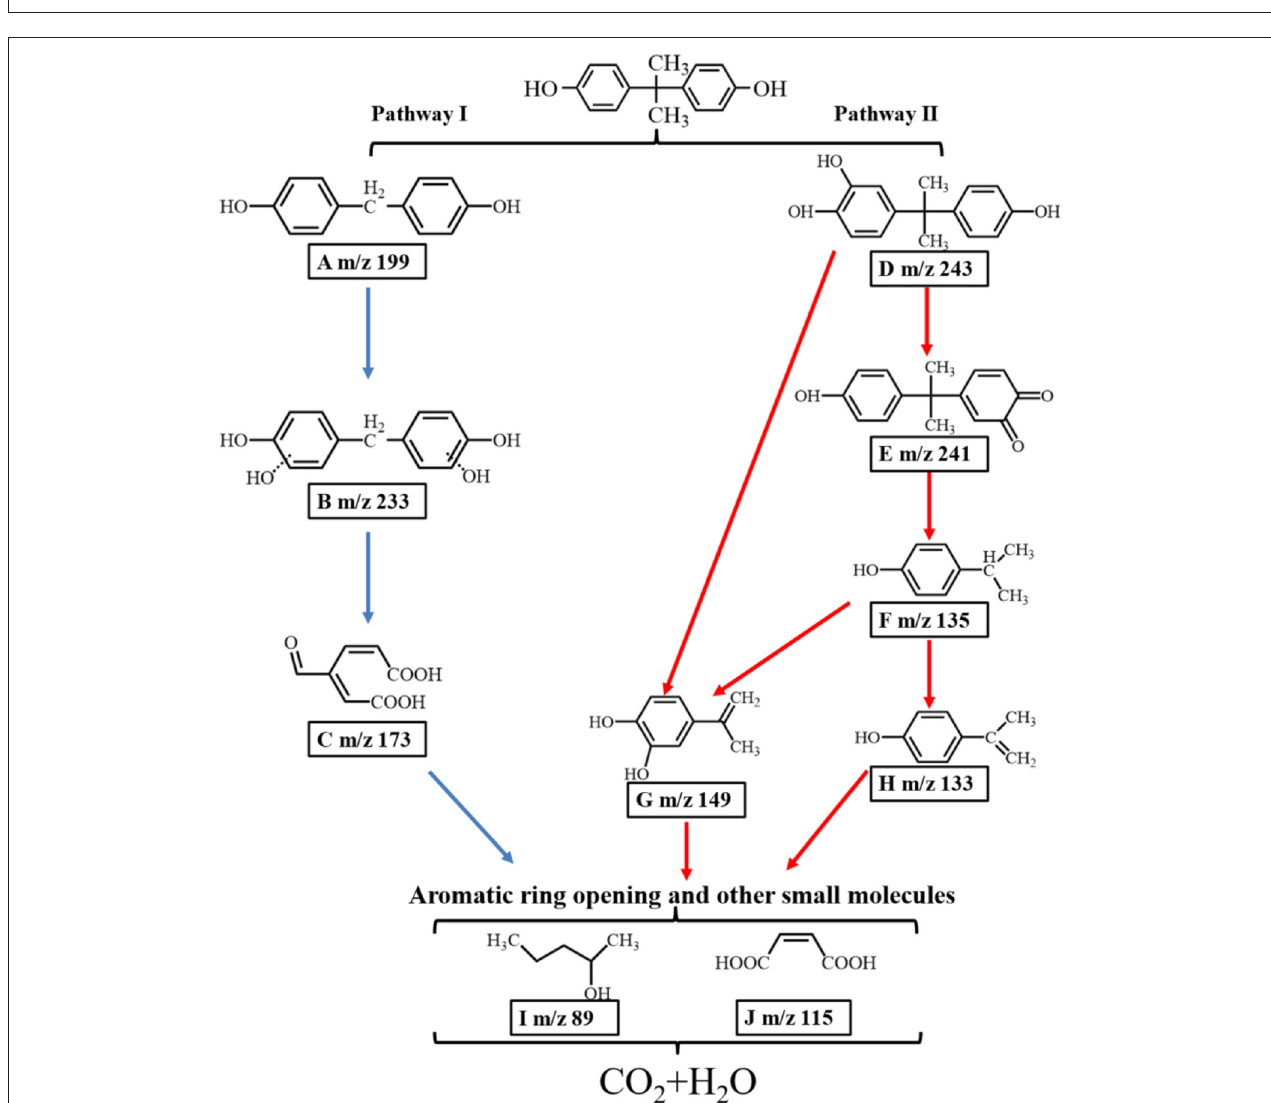
FIGURE 10 | Two proposed photocatalytic degradation pathways of BPA over the ZnO photocatalyst.